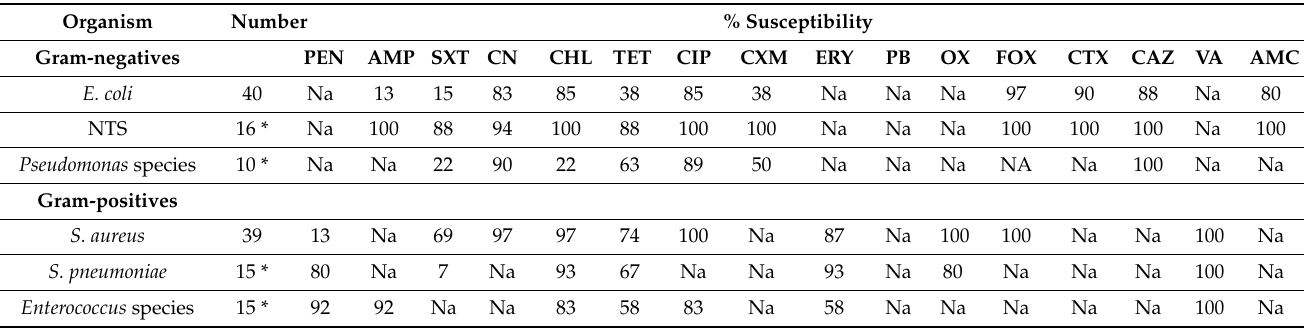
Table 1. Susceptibility profile for the common blood culture pathogens.